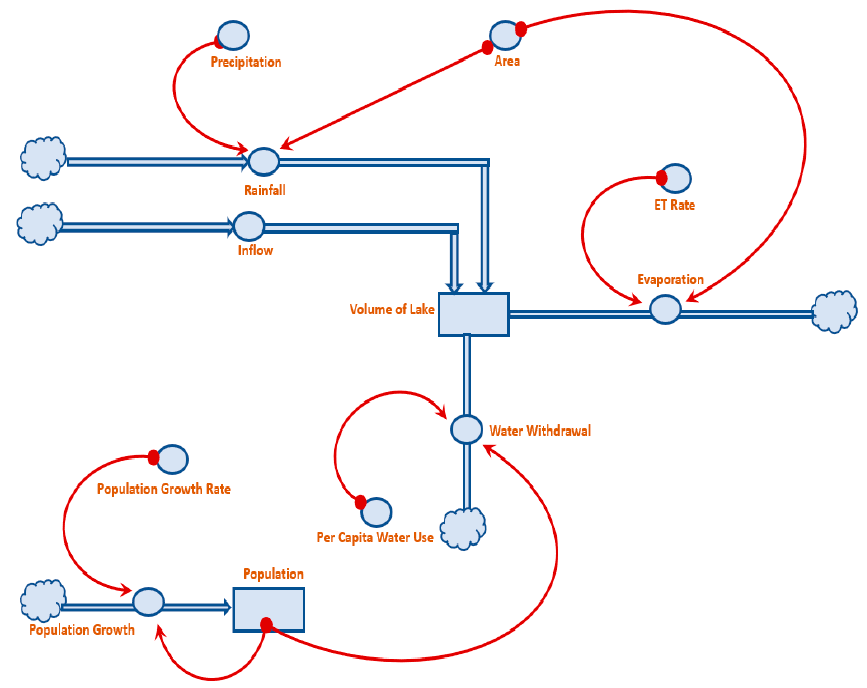
Figure 6. Conceptual model of the Keenjhar Lake by Stella software.